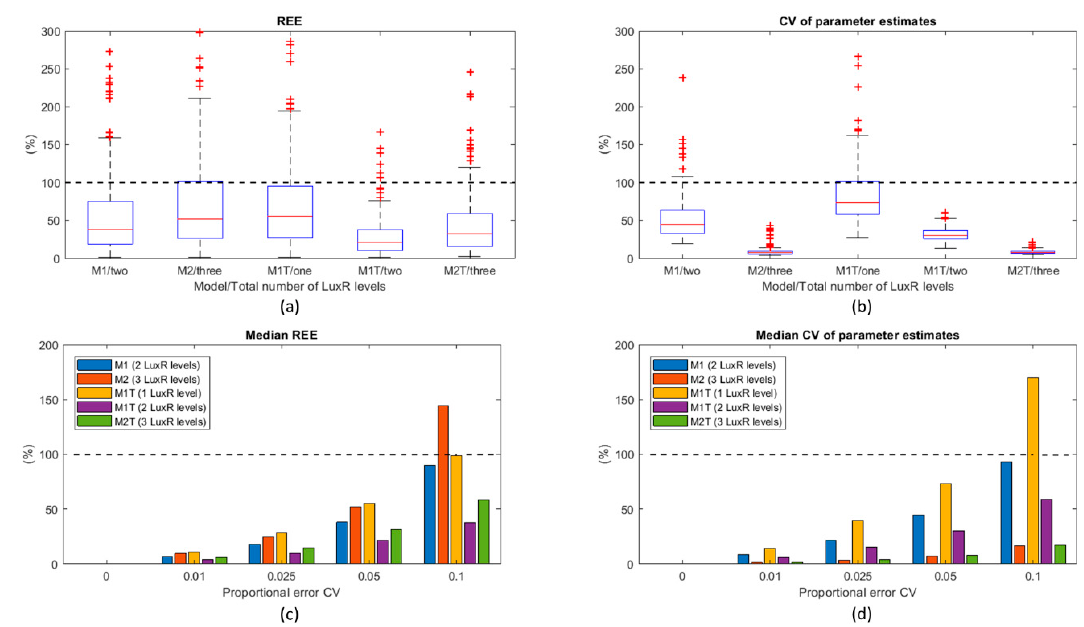
Figure 5. Relative estimation error (REE) and uncertainty of parameter estimates (CV) in a posteriori identifiability. Panels ( a , b ) report the distribution of REE ( a ) and CV ( b ) among 200 runs starting from different simulated data, with a 5% proportional error. The model and the number of LuxR levels included in the fitted data are specified for each boxplot. The red line represents the median of the distribution. Panels ( c , d ) report the median of the REE ( c ) and CV ( d ) distribution as a function of the proportional error entity, from 0 to 10%. The models and specific LuxR levels are described in the legend. In all the panels, the dashed horizontal line indicates the 100% value to facilitate the interpretation of the graphs.